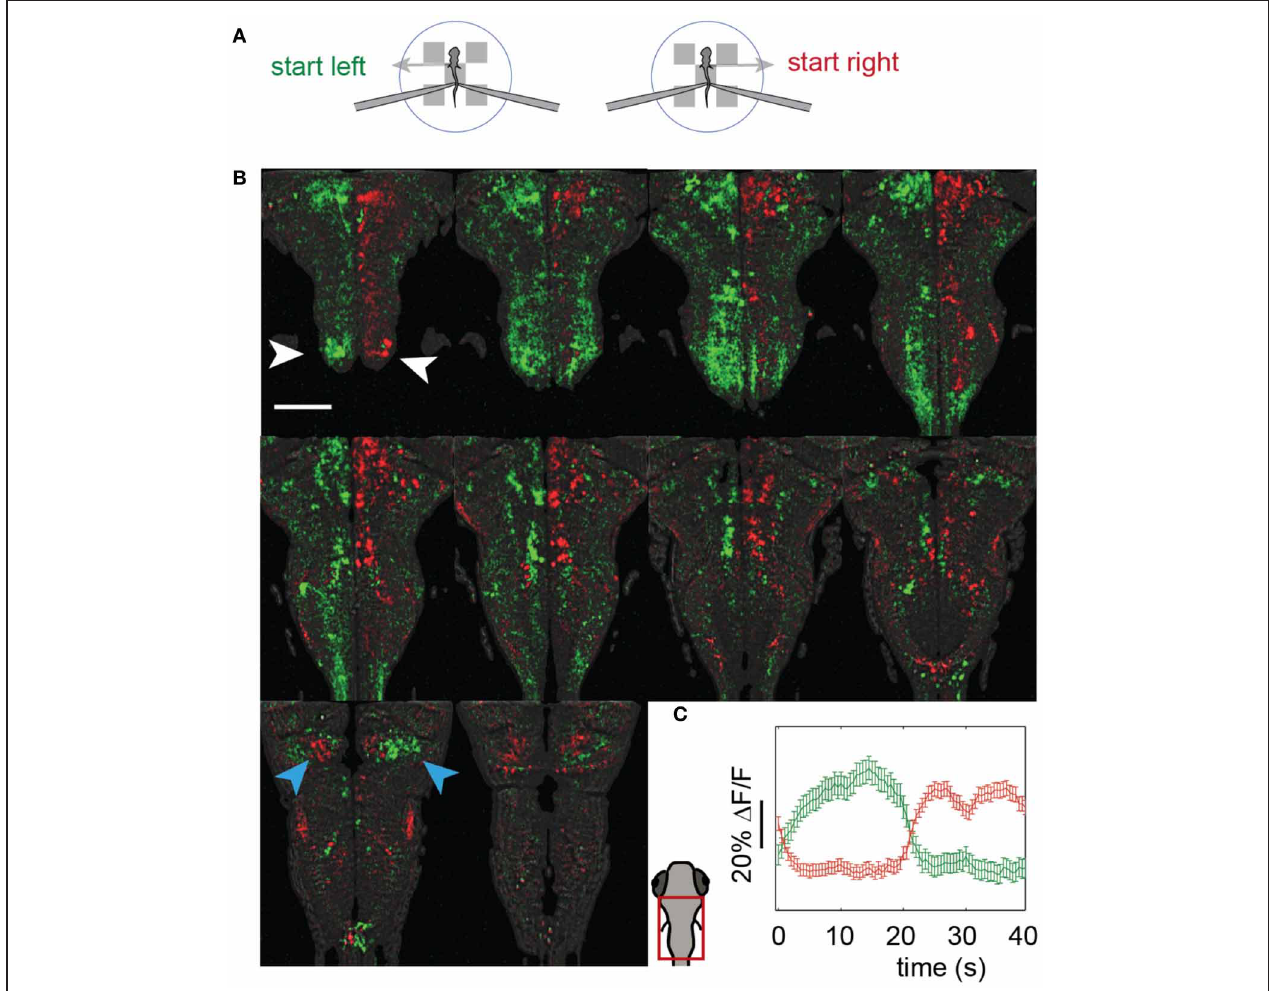
FIGURE 4 | Whole-hindbrain imaging during left/right biased optomotor behavior. (A) Summary of fictive behavioral assay. The assay was identical to the optomotor assay ( Figure 3 ), but the angle was perturbed every 10s and set to leftward (0s), leftward (10s), rightward (20s), rightward (30s), repeating. In this way, the fish was biased to turn left during 20s, and to turn right during 20s. This sequence was repeated twice, over a period of 80s, for each imaged plane. (B) Two-photon imaging of most of the hindbrain during the assay. The imaging area is shown in the schematic of the larval head. Planes 5 μ m apart were imaged each for 80s (A) . Data are displayed as the average of three consecutive planes (i.e., 15 μ m between panels), and